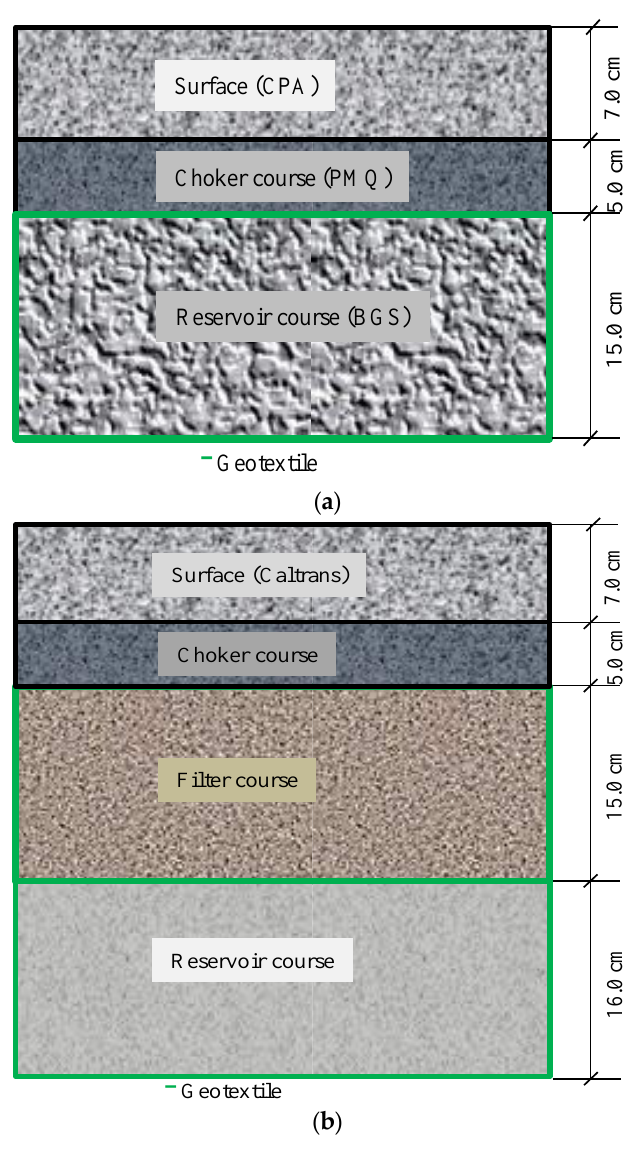
Figure 3. Details of the layers for the two models. ( a ) Model A; ( b ) Model B.